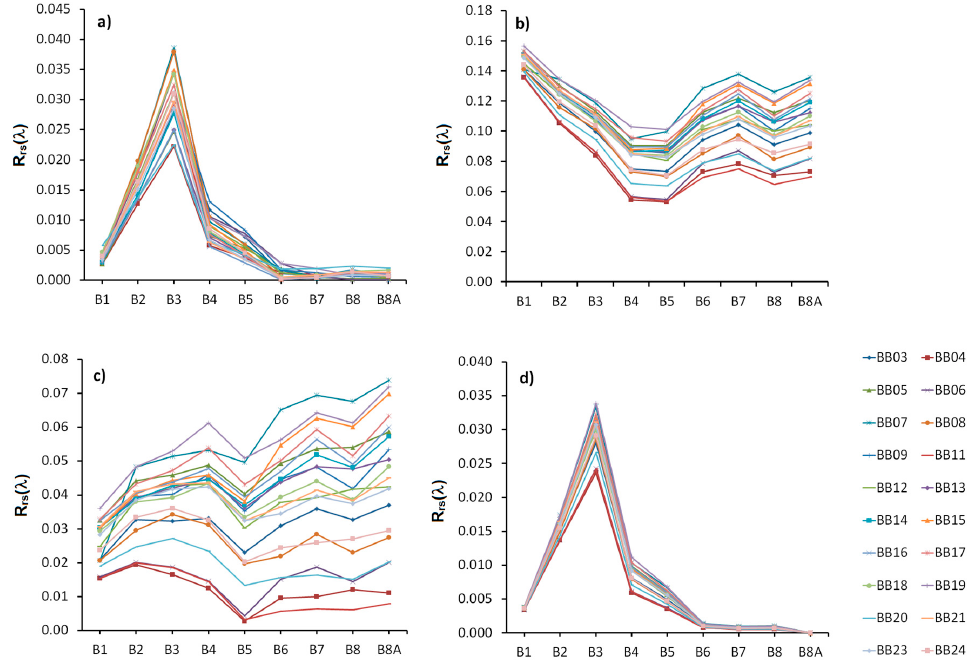
Figure 4. Features of in situ reflectance based on S2A band response-averaged mean values ( a ); TOA reflectance extracted from S2A level 1C ( b ); bottom-of-atmosphere reflectance after using DOS atmospheric correction method ( c ); and bottom-of-atmosphere reflectance after using ELM method ( d ) of pixels that correspond to water sampling points on 5 May 2017. Twenty lines correspond to reflectance spectra curves of 20 water sampling points on 5 May 2017.